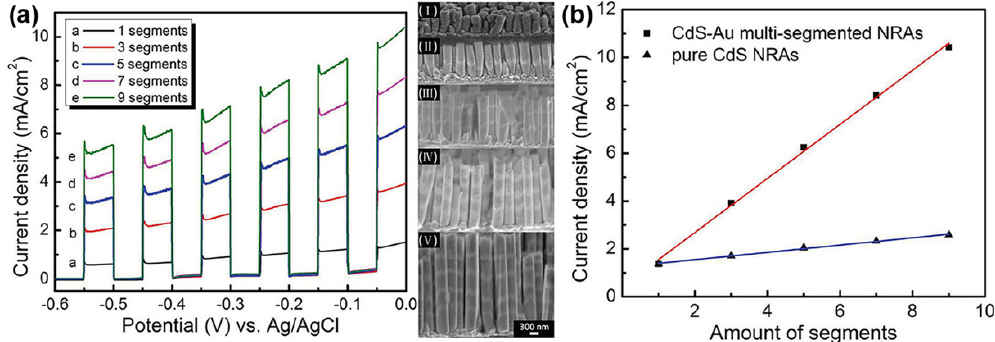
Figure 12. ( a ) Hydrogen evolution through photocatalytic water splitting on Janus Au/TiO 2 , core-shell Au@TiO 2 , amorphous TiO 2 and pristine Au nanoparticles; ( b ) Hydrogen evolution through photocatalytic water splitting on Janus Au/TiO 2 with different Au nanoparticle sizes. Reproduced from [63], with copyright permission from John Wiley & Sons, 2012.